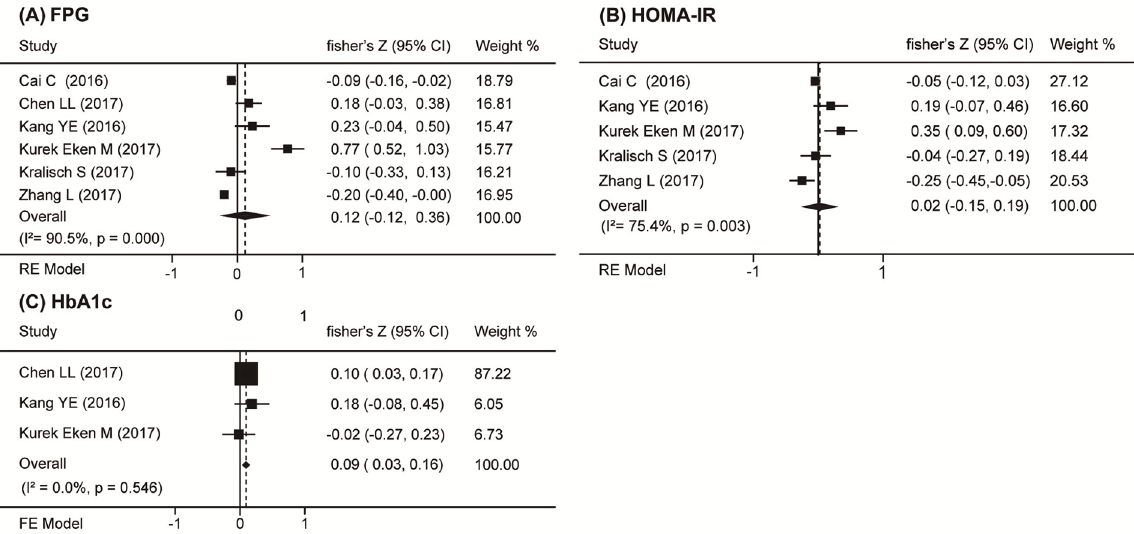
Fig 3. Forest plot of the association between circulation Nrg4 levels and diabetes markers in DM. Summaries are shown of the association circulation Nrg4 levels and (A) FPG, (B) HOMA-IR and (C) HbA1c; FE Model, fixed-effect model.